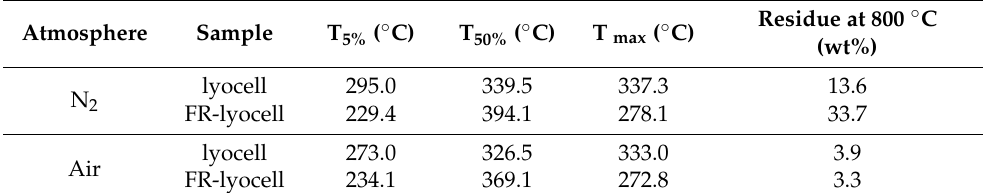
Table 3. TG analysis data of lyocell and FR − lyocell fabrics in N 2 and air atmosphere.